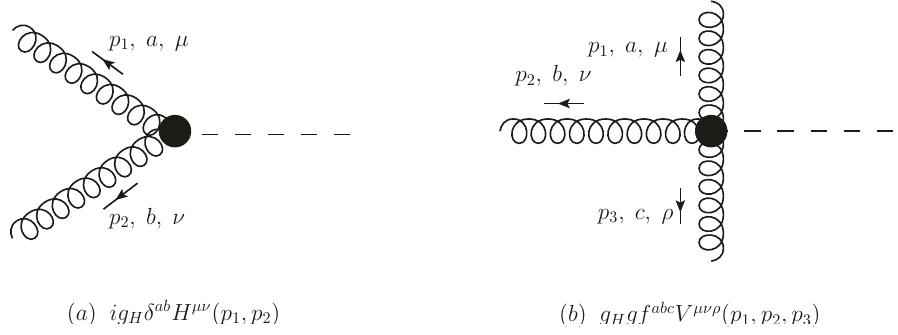
Figure 12 . Feynman rule for the (a) ggH vertex and (b) gggH